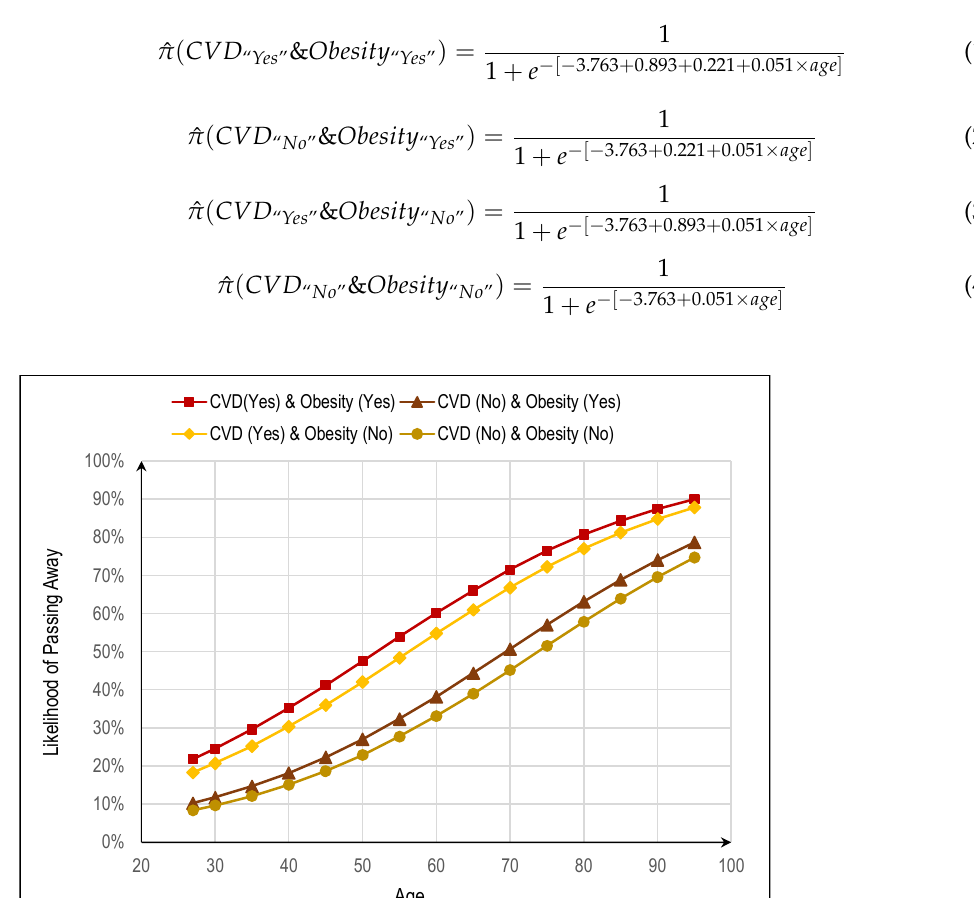
Figure 1. The likelihood that an individual might eventually pass away as a function of age , obesity ,